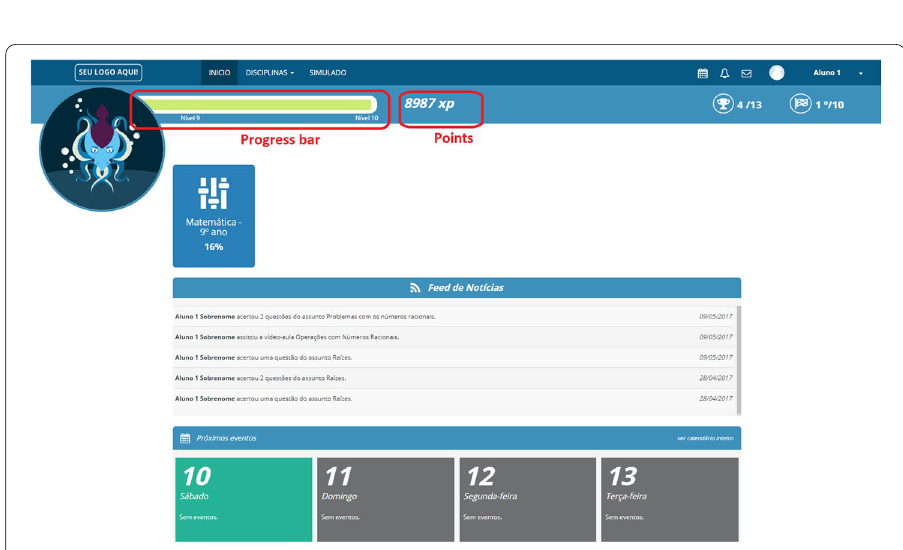
Fig. 3 MeuTutor default version